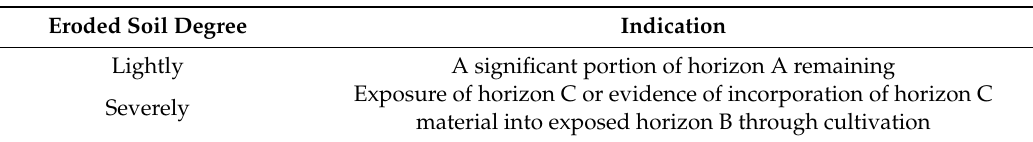
Table 1. Classification of soil